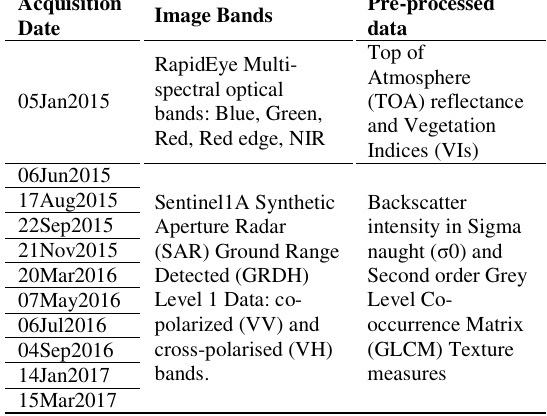
Table1: Remote sensing data acquisition; mono-date RapidEye (5m) and multi-date Sentinel1 SAR (10m)